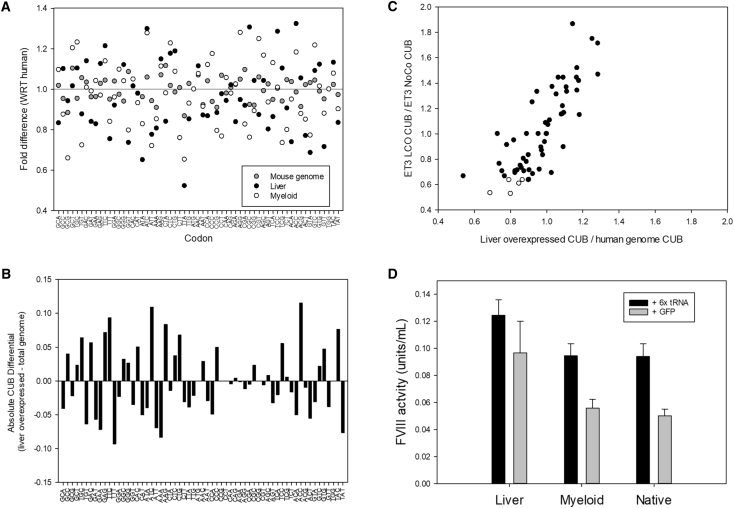
Liver-Directed Codon Optimization(A) The fold difference in CUB of each codon in the liver CUB table with respect to the same codon in the human CUB table, as defined in formula 2. (B) The absolute difference codon usage bias of each codon in the liver CUB table versus the respective codon in the human CUB table, as defined by formula 3. (C) The correlation of the ratio of CUB for the set of liver genes to that of the entire human genomic coding sequence against the correlation of the ratio of CUB for ET3-LCO to that of ET3-NoCo. Points represent individual codon species. Open circles denote the 6 codon species with the lowest ratio of ET3-LCO to ET3-NoCo. Due to overlapping positions, two open circles appear as a single point. (D) Plasmid DNA encoding codon-optimized variants of ET3 were co-transfected into HepG2 cells with either GFP expression plasmid or a plasmid encoding the six tRNAs predicted to be most limiting of the expression of ET3-NoCo (*p < 0.05 by two-tailed t test).